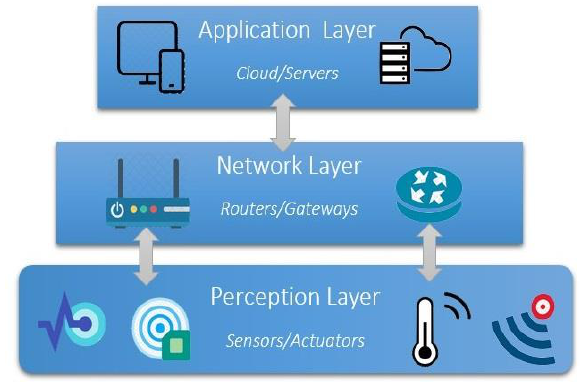
Figure 1 : IoT three-layer